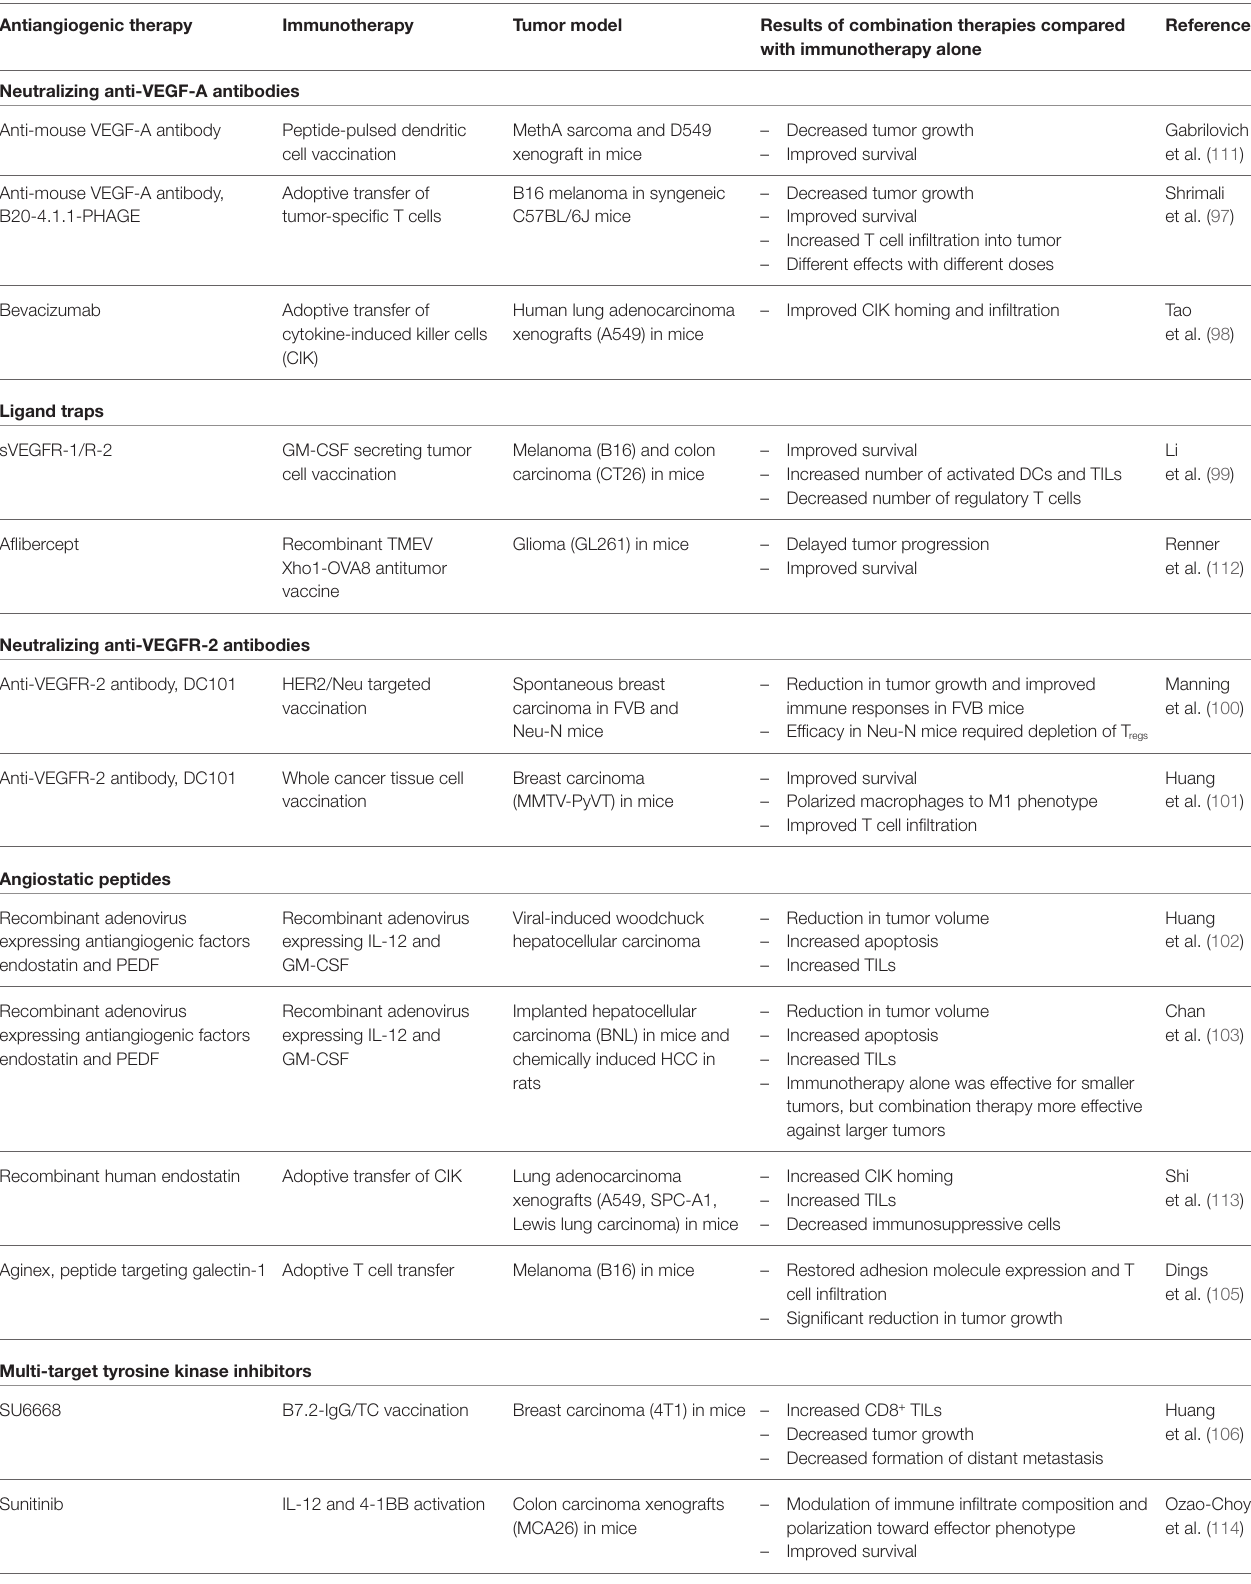
TABLe 1 | Summary of pre-clinical studies combining antiangiogenic therapies and